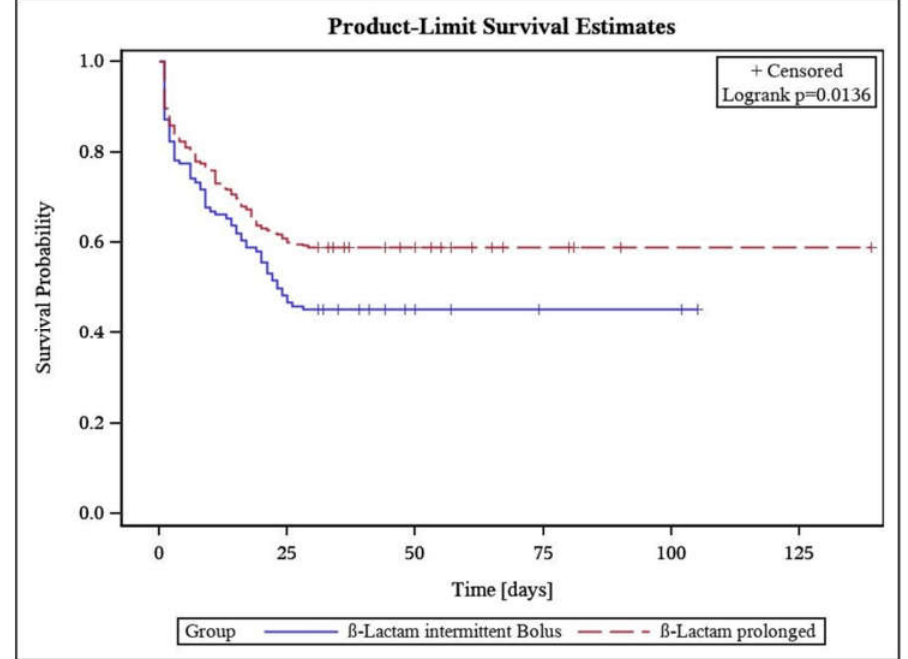
Figure 2. Kaplan-Meier product-limit survival estimates in intermittent bolus and prolonged infusion group. Table 3. Primary endpoints in baseline cohort and propensity-score matched patients. Baseline ( n = 414) Propensity-score Matched ( n = 224)